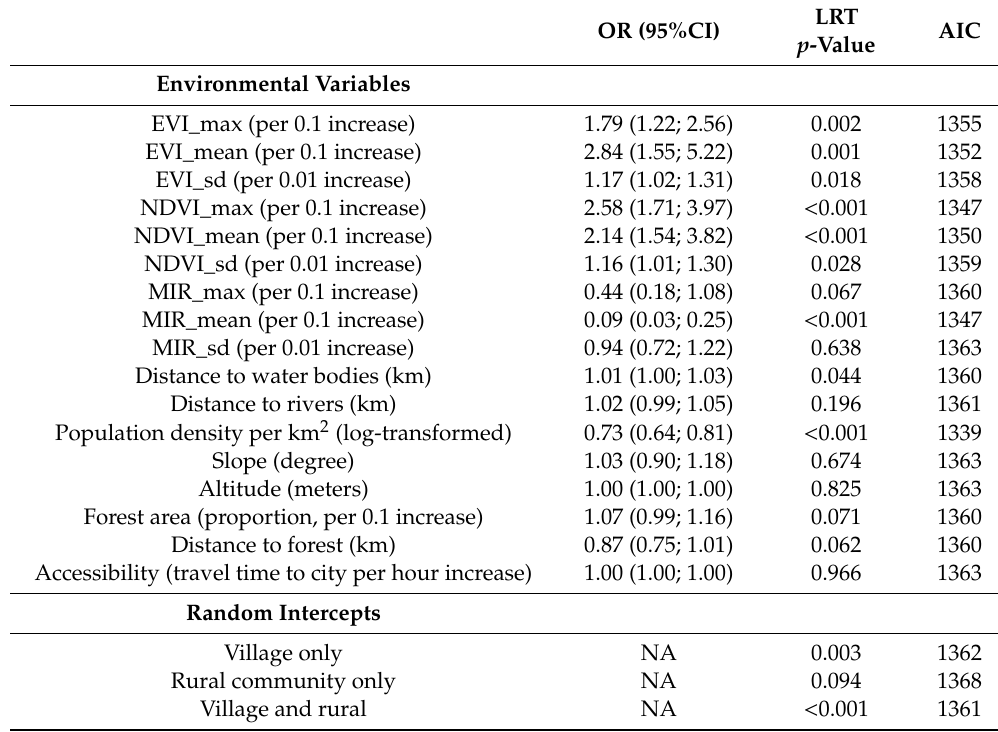
Table A1. Univariable analysis of the association between CHIKV seroprevalence and environmental variables using 3km bu ff ers around villages. The models were adjusted for clustering of individuals in villages and rural communities (random intercept).